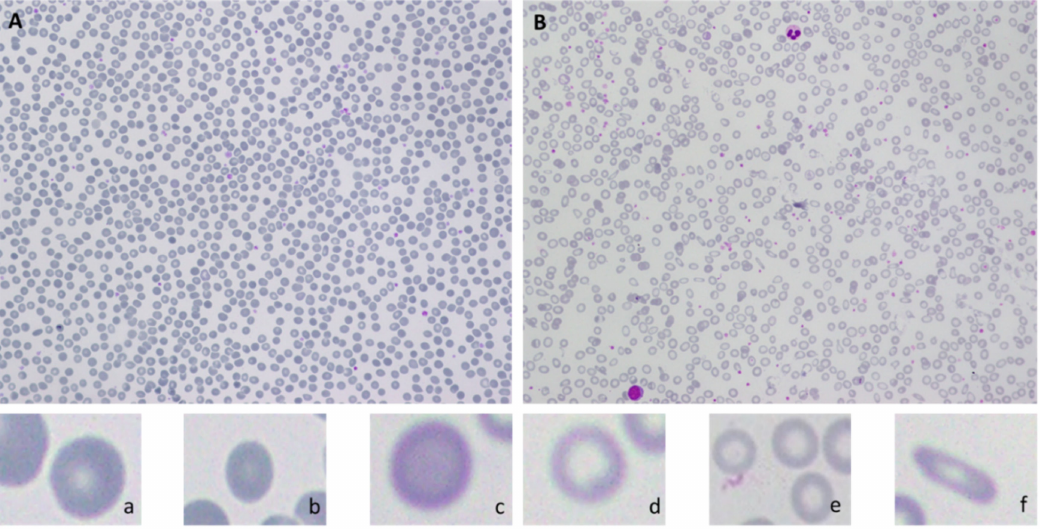
Figure 2. Description of proposed anemic-RBC dataset. Different RBC elements included in im- ages are: ( A ) An image that contains healthy RBC elements, ( B ) An image that contains abnormal RBC elements due to anemia. ( a ) Normal RBC, ( b ) Microcytic RBCs having a size less than usual, ( c ) Macrocytic RBCs having a size greater than Normal, ( d ) Macrocytic Hypochromic having greater size with reduced hemoglobin, ( e ) Microcytic Hypochromic having a size less than normal with reduced hemoglobin and ( f ) Elliptocytes having an oval or elongated